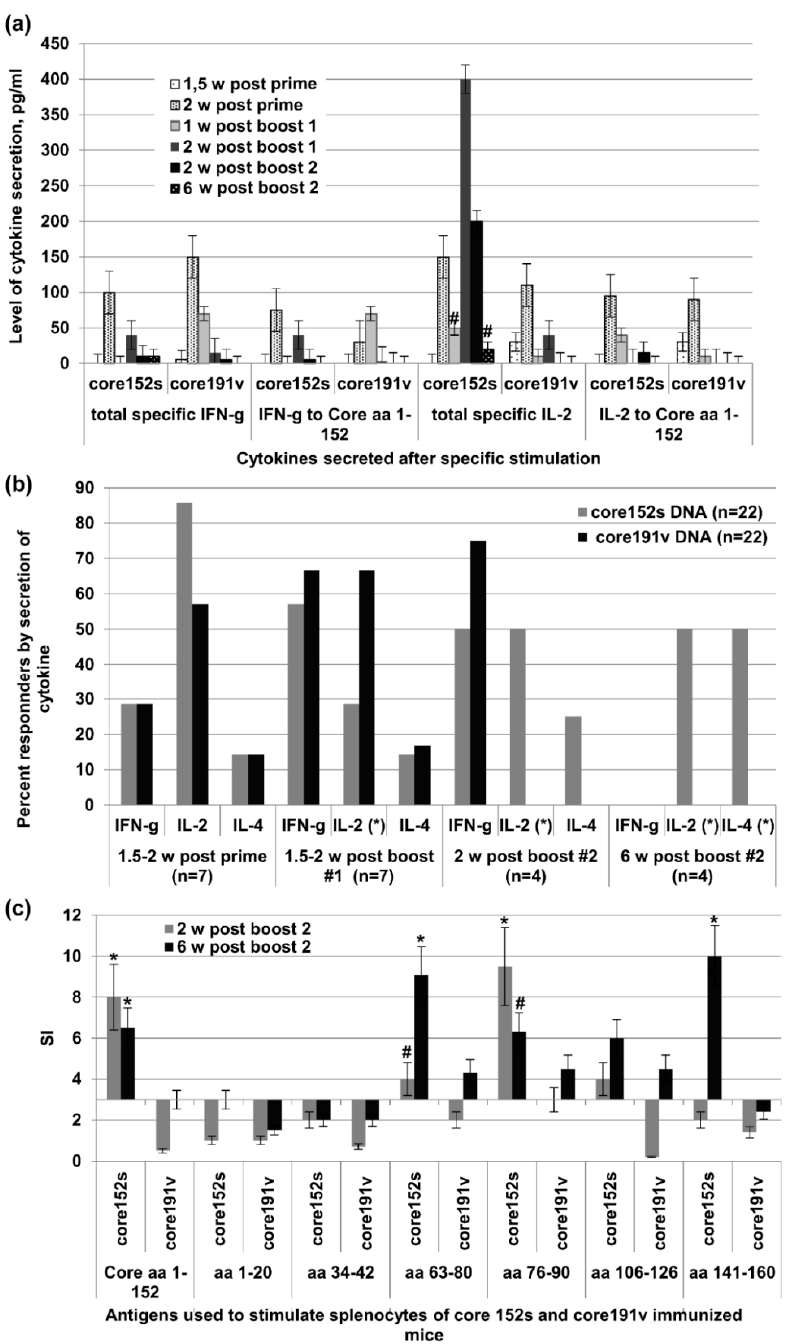
Figure 6. Cellular immune response of C57Bl/6 mice to DNA-immunization with HCV core gene variants delivered by intramuscular injections. ( a ) Secretion of IFN- γ and IL-2 by the splenocytes of mice DNA-immunized with core152s ( n = 22) or core191v ( n = 22) and stimulated with the recombinant HCV core or core-derived peptides 1.5 or two weeks after the prime, one and two weeks post the 1 st boost, and two or six weeks post the 2nd boost; ( b ) Percent of mice responding to T-cell stimulation by the secretion of IFN- γ , IL-2 and IL-4 at different time points of immunization cycle; ( c ) Proliferative response of mouse splenocytes to in vitro stimulation with HCV core and core-derived peptides two and six weeks post the last DNA immunization. * denotes a significant difference between the values demonstrated by the recipients of core152s and core191v DNA ( p < 0.05); #-tendency for difference between the values demonstrated by the recipients of core152s and core191v DNA (0.05 < p < 0.15). Cellular response data for each time point correspond to a different set of mice sacrificed to perform the cellular test. All assays were done in duplicates. Statistical analysis was done by Mann–Whitney test.